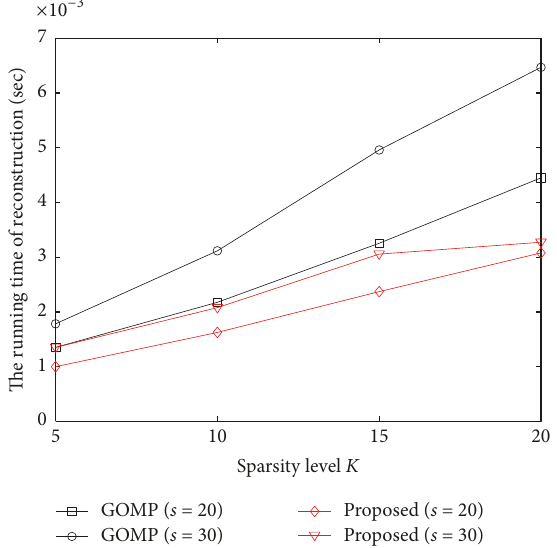
Figure 5: The average running time of GOMP and the proposed method with a large 𝑆